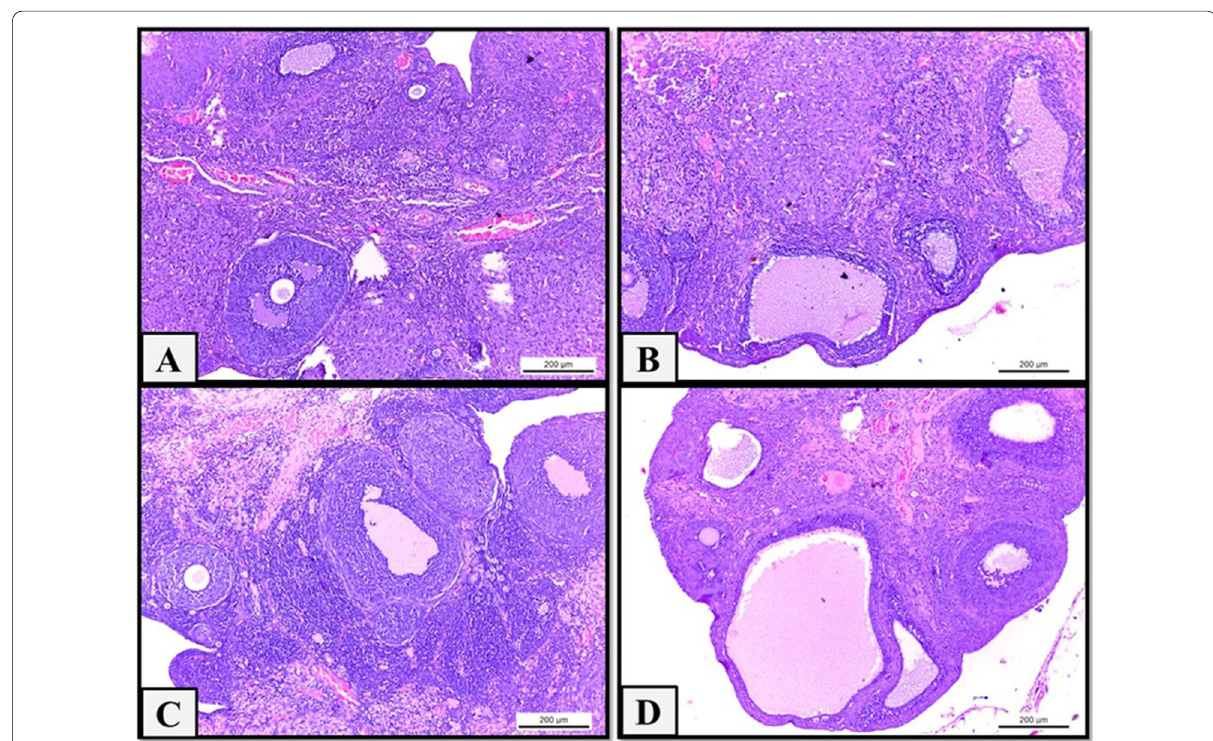
Fig. 4 A photomicrograph of H&E-stained sections (100 ) of the ovary of female albino rat showing: A control ovary with normal ovarian follicles × and corpus luteum in different stages of development. B PCOS group with numerous ovarian cysts. The cysts appeared thin walled with degraded granulosa cells, degenerated oocyte and pale acidophilic residues. C PCOS LC group with ovarian cysts. The cysts appeared smaller in size. Notice + the increase in the granulosa cell layer. D PCOS CLO group nearly the same as LTZ group. C: Control group, PCOS: letrozole induced polycystic + ovarian syndrome, PCOS LC: letrozole induced polycystic ovarian syndrome treated with l -Carnitine, PCOS CLO: letrozole induced polycystic + + ovarian syndrome treated with Clomiphene Citrate